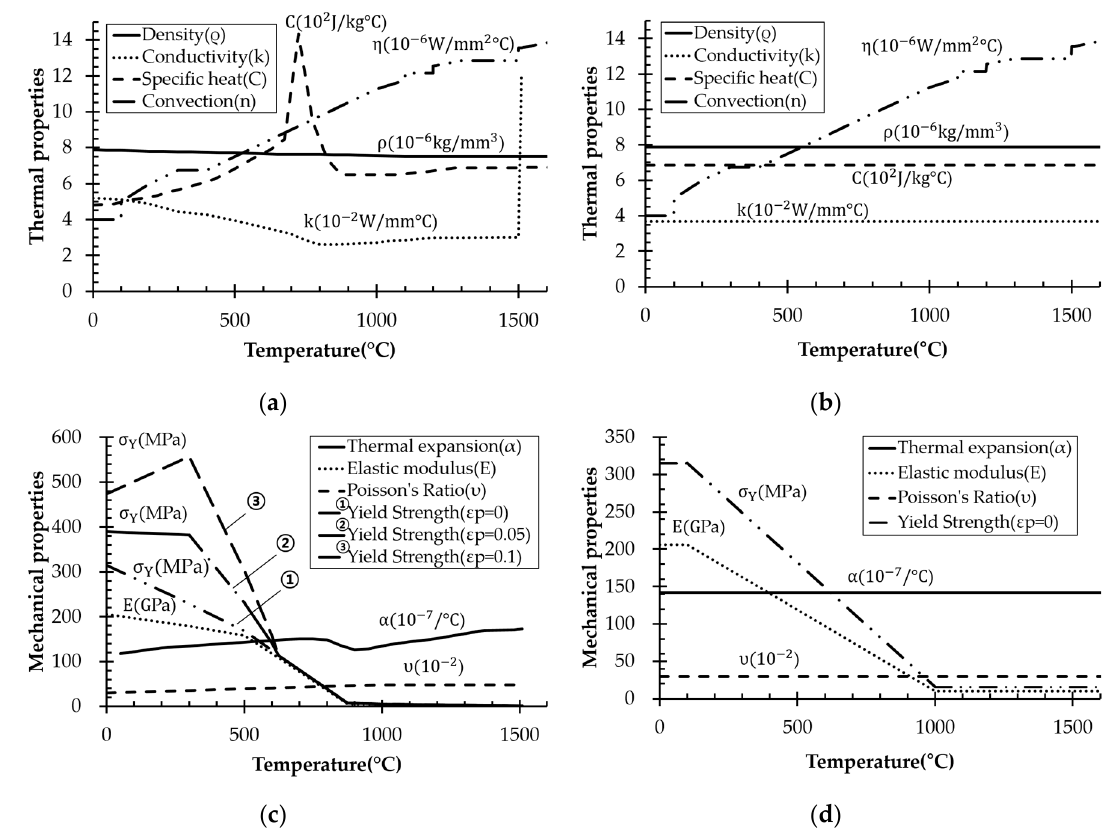
Figure 5. Thermal properties ( a ) and ( b ) and corresponding mechanical properties ( c ) and ( d ) of temperature-dependent and reference models for AH32 steel.